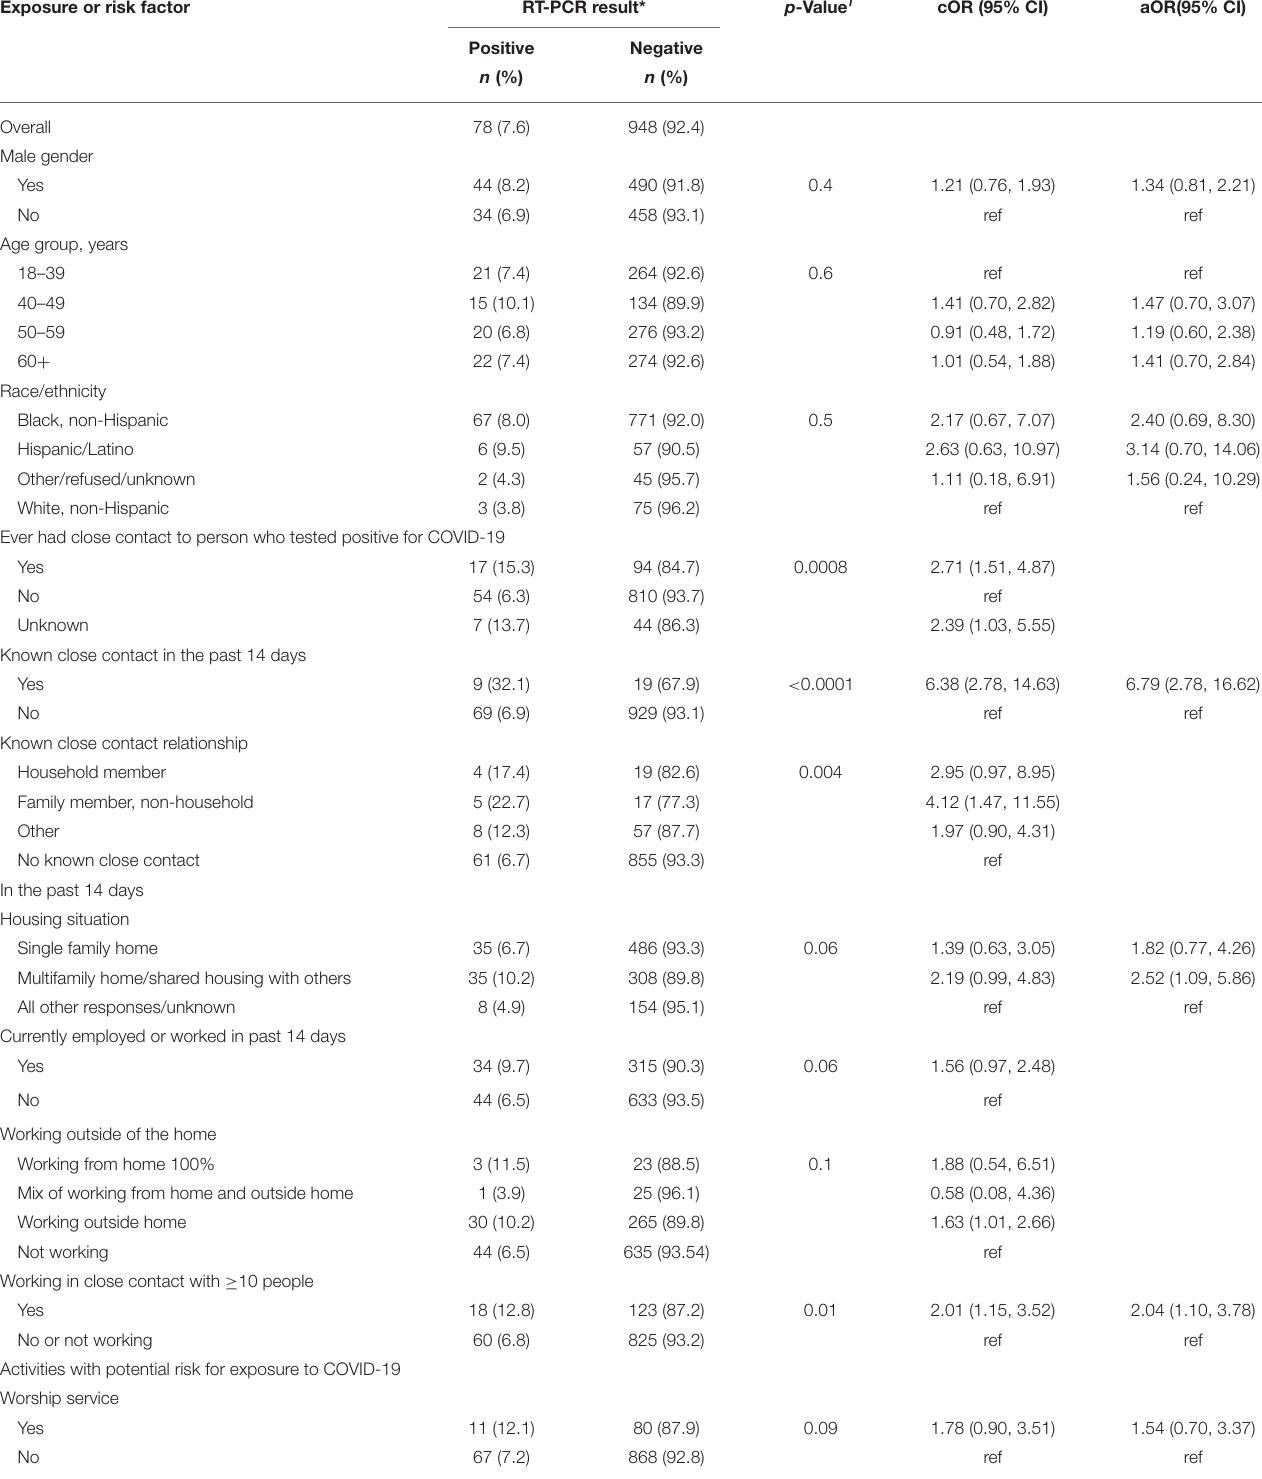
TABLE 2 | Associations between known and potential exposures to SARS-CoV-2 infected persons and testing positive for the virus; a study at a large urban, public hospital in Fulton County, GA, August-November 2020 ( n = 1,026). Exposure or risk